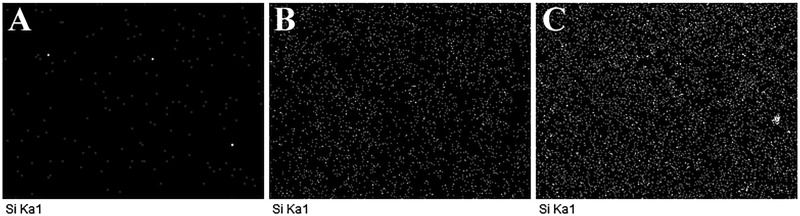
EDX mapping of silicon for PLGA (A), PLGA/SiO2-2.5 (B) and PLGA/SiO2-5 (C)